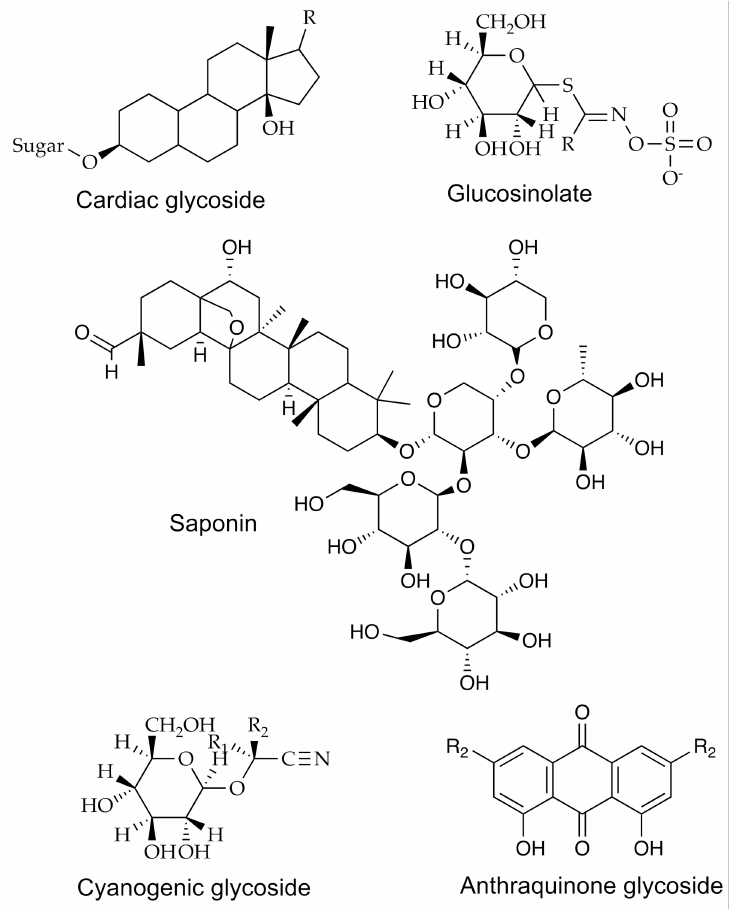
Figure 1. The chemical structures for some glycosides. Table 1. Some bioactive compounds from plants, their properties, and the methodologies used for their identification and